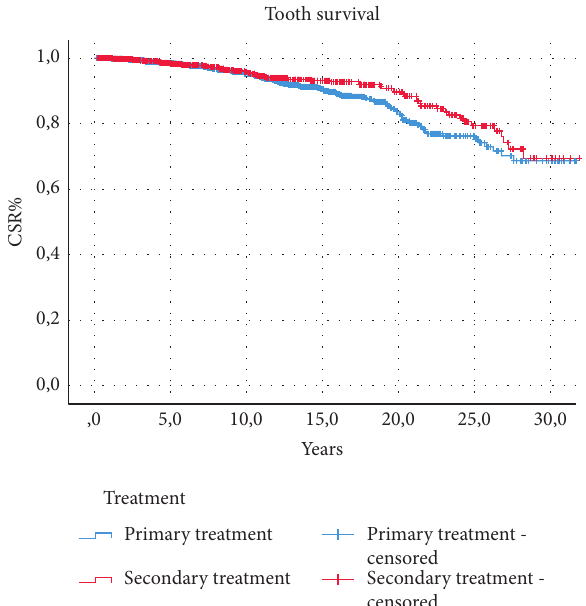
Figure 3: Survival function comparing primary and secondary treatments (Kaplan–Meier).